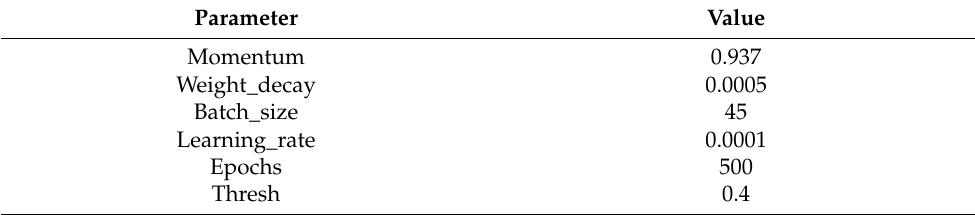
Table 1. Training parameter settings.